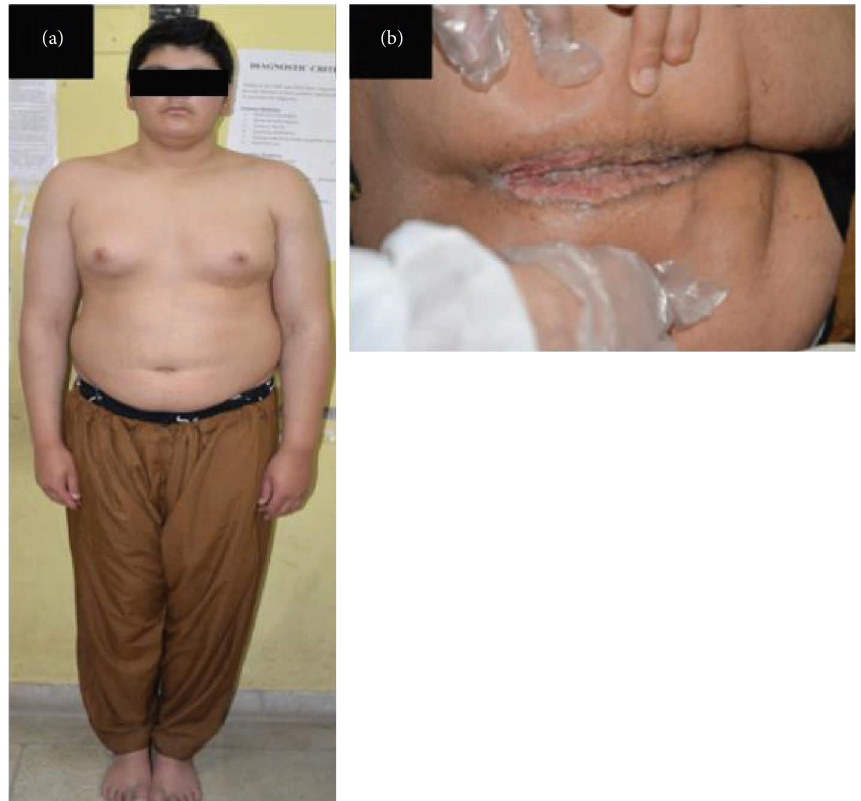
Figure 1: Clinical image of the patient showing (a) gynaecomastia and absent body and facial hair (b) perianal ulcers.